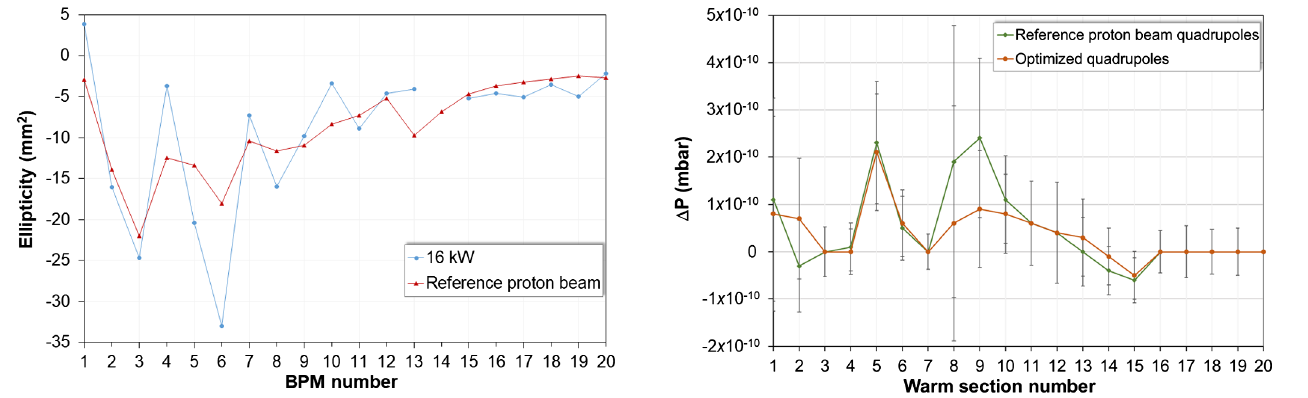
FIG. 8. Pressure variation in the warm sections of the SC linac with the MEBT quadrupoles for the reference proton beam (green) and after optimization